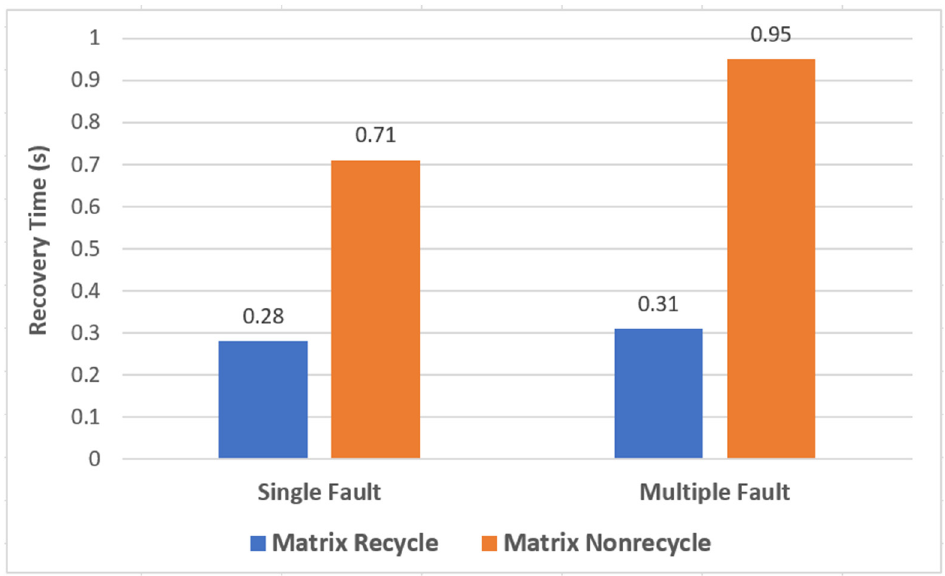
Figure 26. Performance comparison according to the matrix recycle.